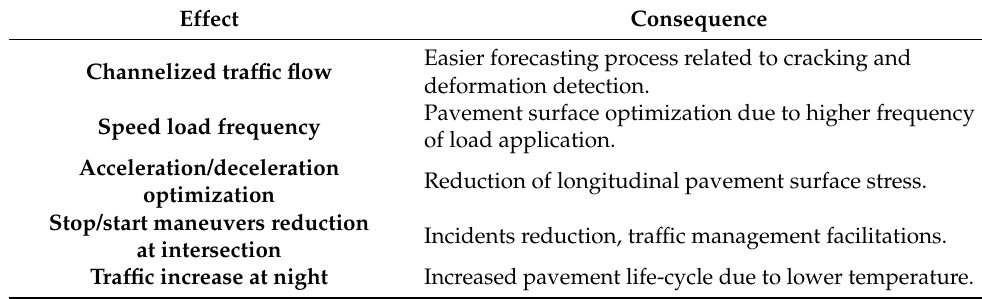
Table 4. Overview of AVs effects on pavement